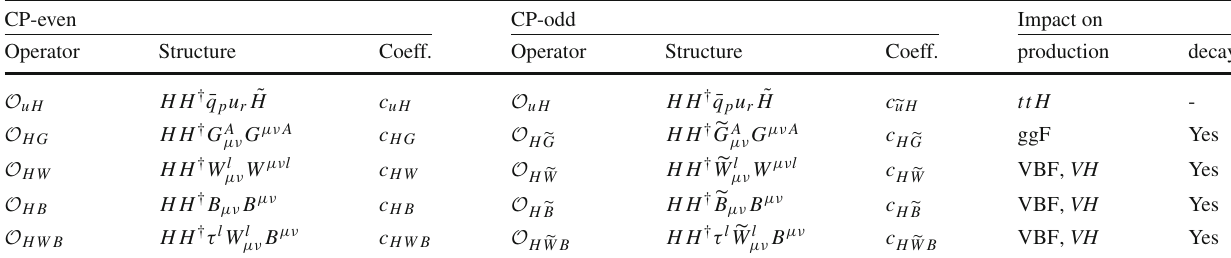
Table 1 Summary of EFT operators in the SMEFT formalism that are probed in the H → Z Z ∗ → 4 (cid:4) channel. The corresponding tensor structure in terms of the SM fields from Ref. [29] is shown together with the associated Wilson coefficients, the affected production ver- tices and the impact on the H → Z Z ∗ decay vertex. The Higgs doublet field and its complex conjugate are denoted as H and (cid:3) H ,